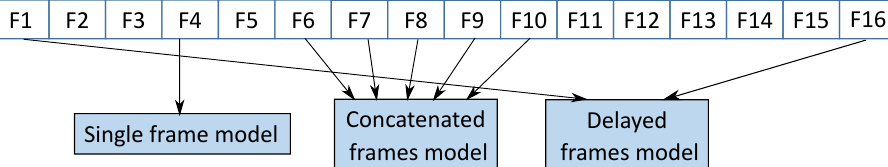
Figure 5. Some of the explored approaches for capturing spatio–temporal features: a single frame model which processes one image at a time; a concatenated frames model which processes consecutive 5 frames at a time; a delayed frames model which processes two frames at a time that are 15 frames apart